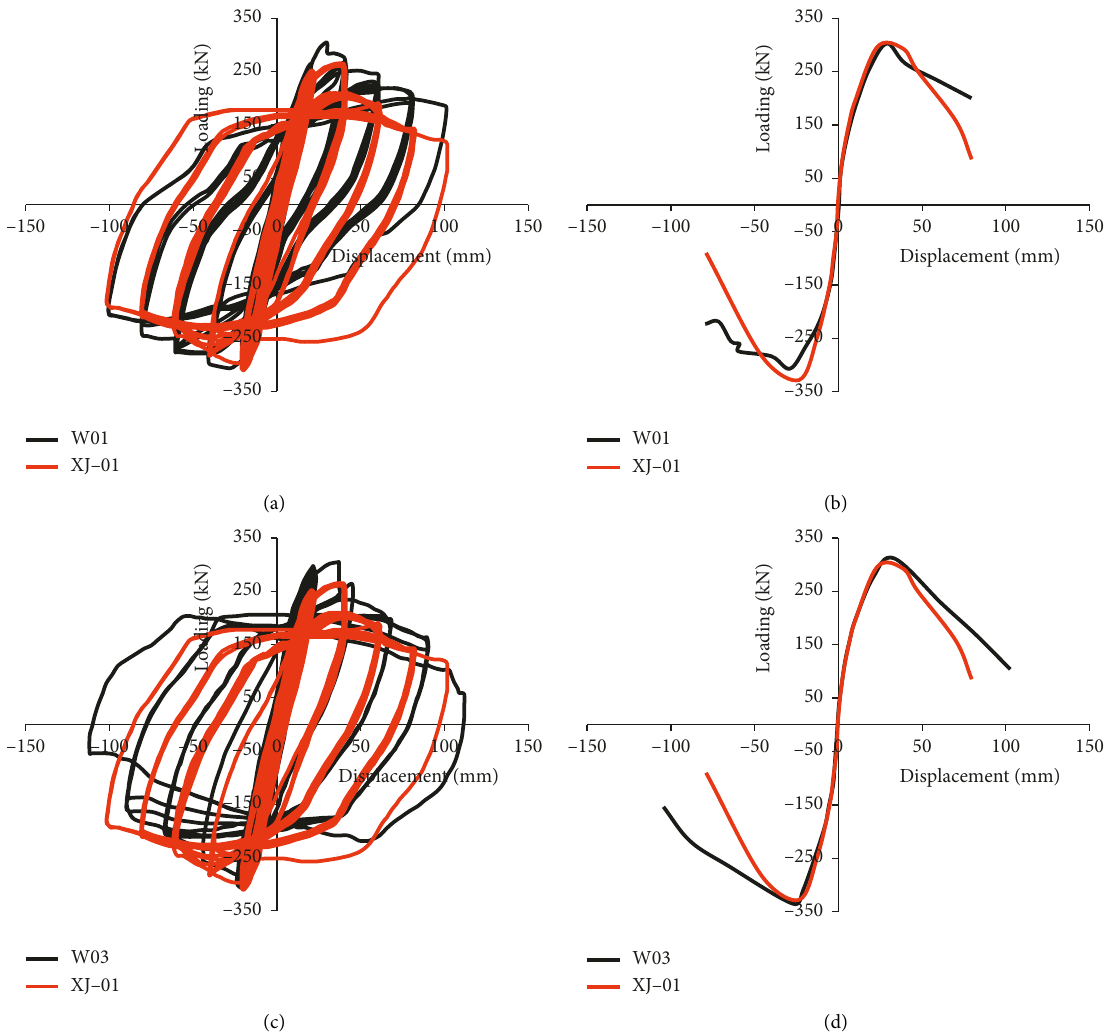
Figure 8: Comparison of hysteresis curves and skeleton curves of specimens with different manufacturing processes. (a) Comparison of hysteresis curves between W01 and XJ-01. (b) Comparison of skeleton curves between W01 and XJ-01. (c) Comparison of hysteresis curves between W03 and XJ-01. (d) Comparison of skeleton curves between W03 and